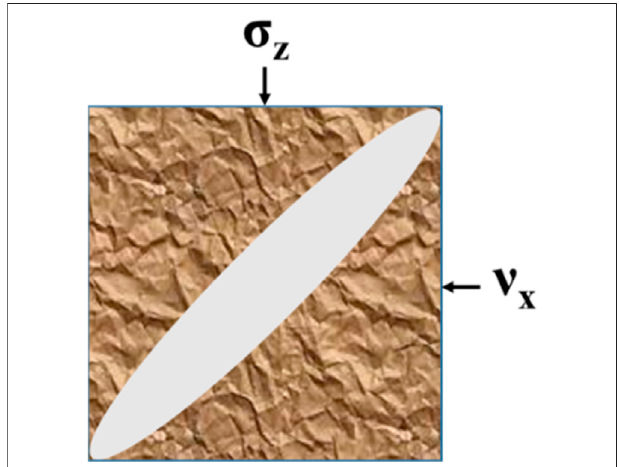
FIGURE 2 | Schematic diagram of the stress state of the crack (Wang,